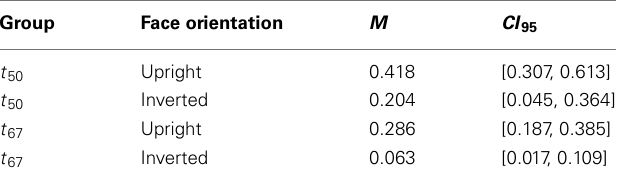
Table 1 | Mean and 95% confidence intervals for masking averaged across noise orientations.